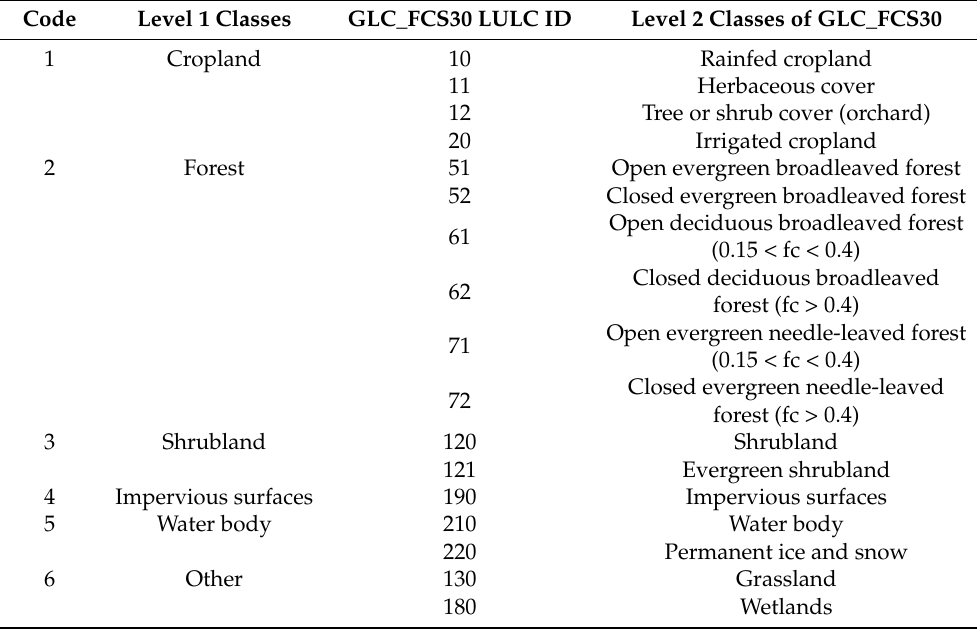
Table 1. LULC classification system in Vietnam.